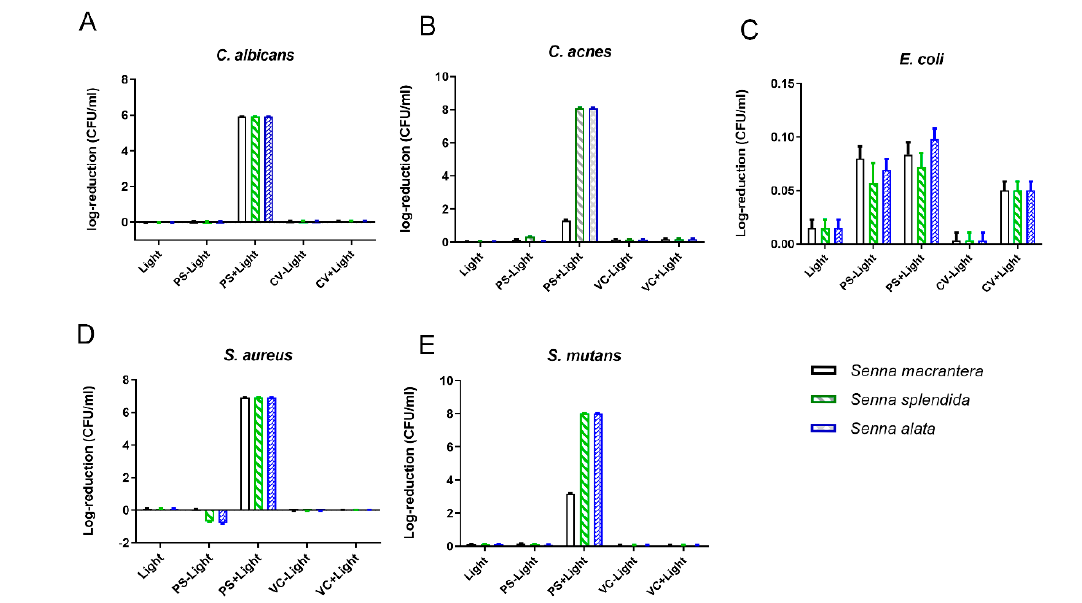
Figure 2. Effect of PDT of plant extracts (0.05 mg/mL) on microorganisms in suspensions (mean ± 95% confidence interval). ( A ) = Candida albicans ; ( B ) = Cutibacterium acnes ; ( C ) = Escherichia coli ; ( D ) = Staphylococcus aureus ; ( E ) = Streptococcus mutans . PS − light = plant material not exposed to light; PS + light = plant material exposed to light; VC − light = vehicle control not exposed to light; VC + light = vehicle control exposed to light.